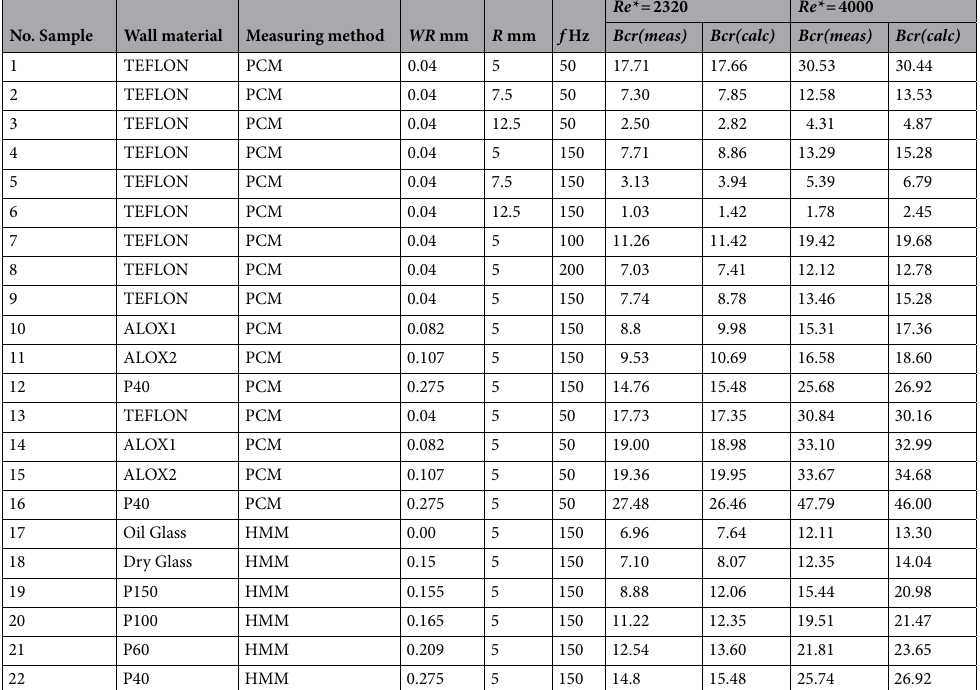
Table 2. The characterisation of the samples and the measured and calculated critical magnetic induction values ( Bcr ) using the pressure compensation method (PCM) and height measuring method